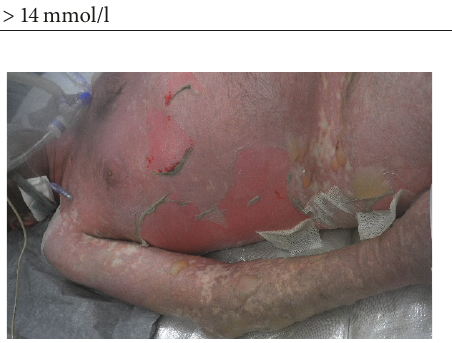
Figure 2: Toxic epidermal necrolysis. Cessation of progression after